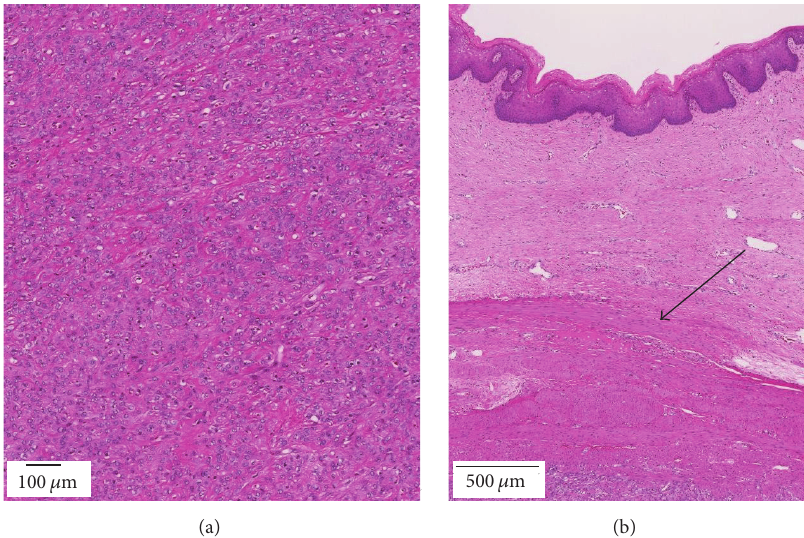
Figure 3: (a) Microscopic findings show the tumor with epithelioid short spindle-cell growth without necrosis. Nuclear pleomorphism is mild. No mitotic activity is present. (b) The tumor involves the vaginal smooth muscle layer and originated ( → ) from the vaginal